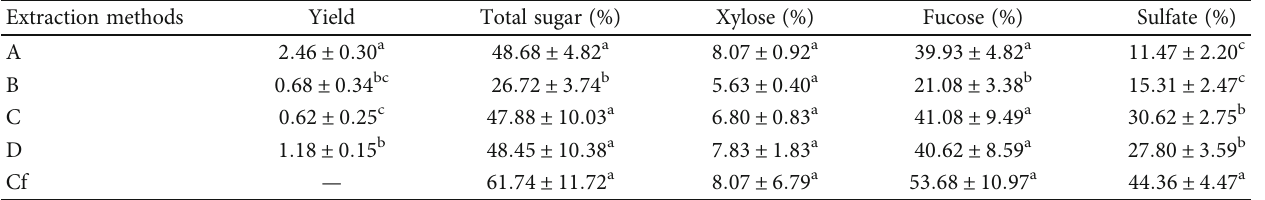
Table 1: The extraction methods on fucoidan yield, total sugar, xylose, fucose, and sulfate contents derived from S. hystrix. Extraction methods